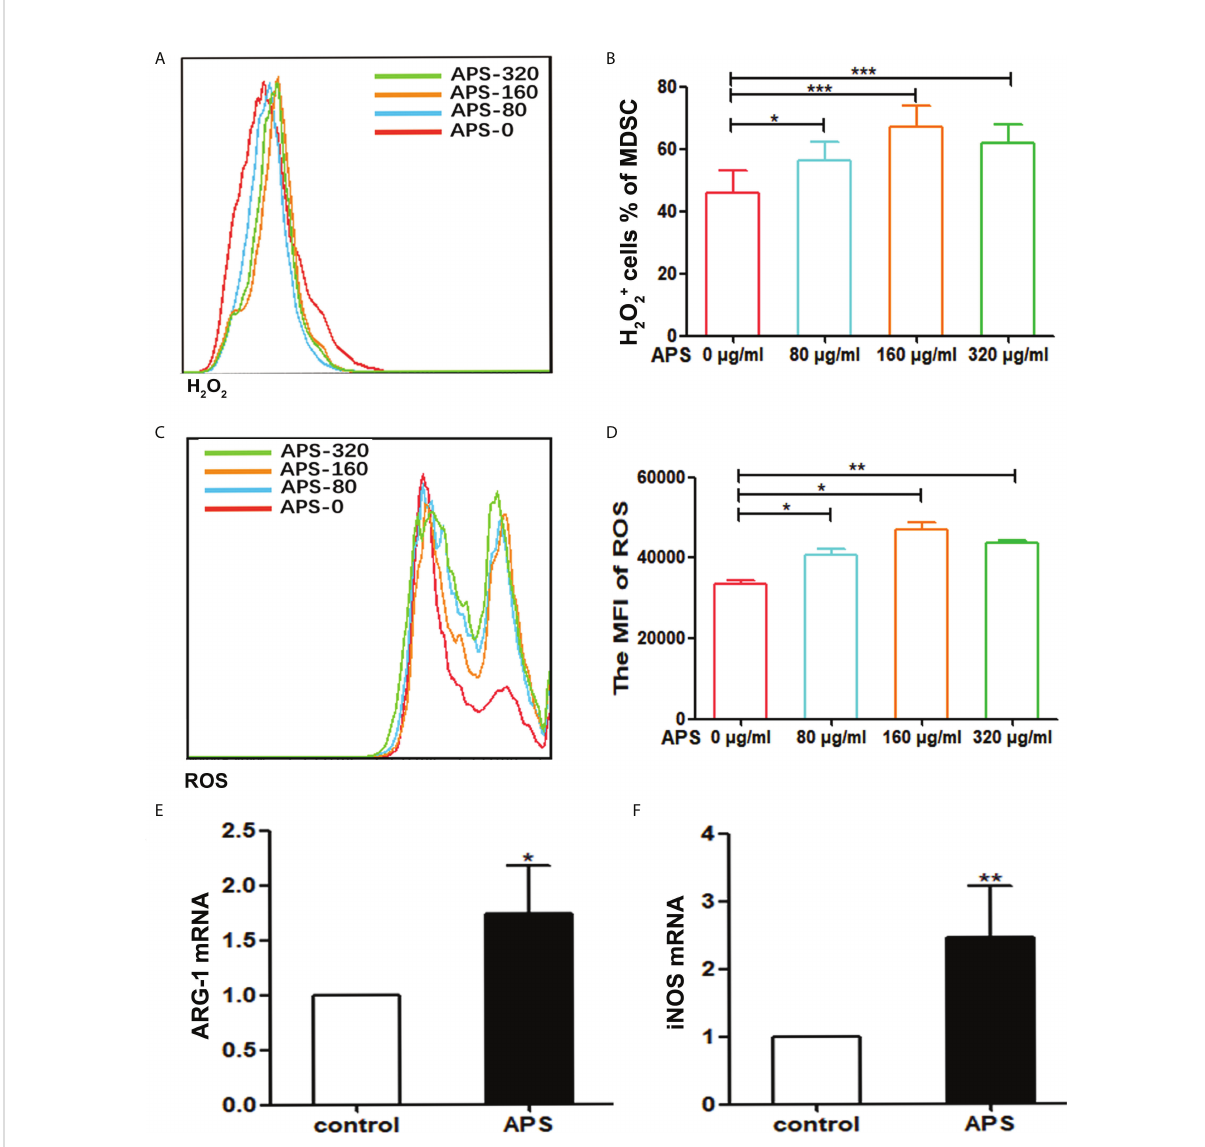
FIGURE 3 APS increases H 2 O 2 , ROS production and the expression of MDSC-associated genes. MDSC were isolated from peripheral blood, spleen and bone marrow from tumor-bearing mice using anti-mouse Ly-6G and Ly-6C particle-DM, then they were treated with APS (0, 80, 160 and 320 m g/ml) for 48h. (A, C) One representative result from each experiment is shown. The H 2 O 2+ cells% (B) and the MFI of the ROS detection (D) in the isolated MDSC (*** p<0.001, ** p<0.01, * p<0.05). The expression of the MDSC associated genes ARG-1 (E) and iNOS (F) was analyzed